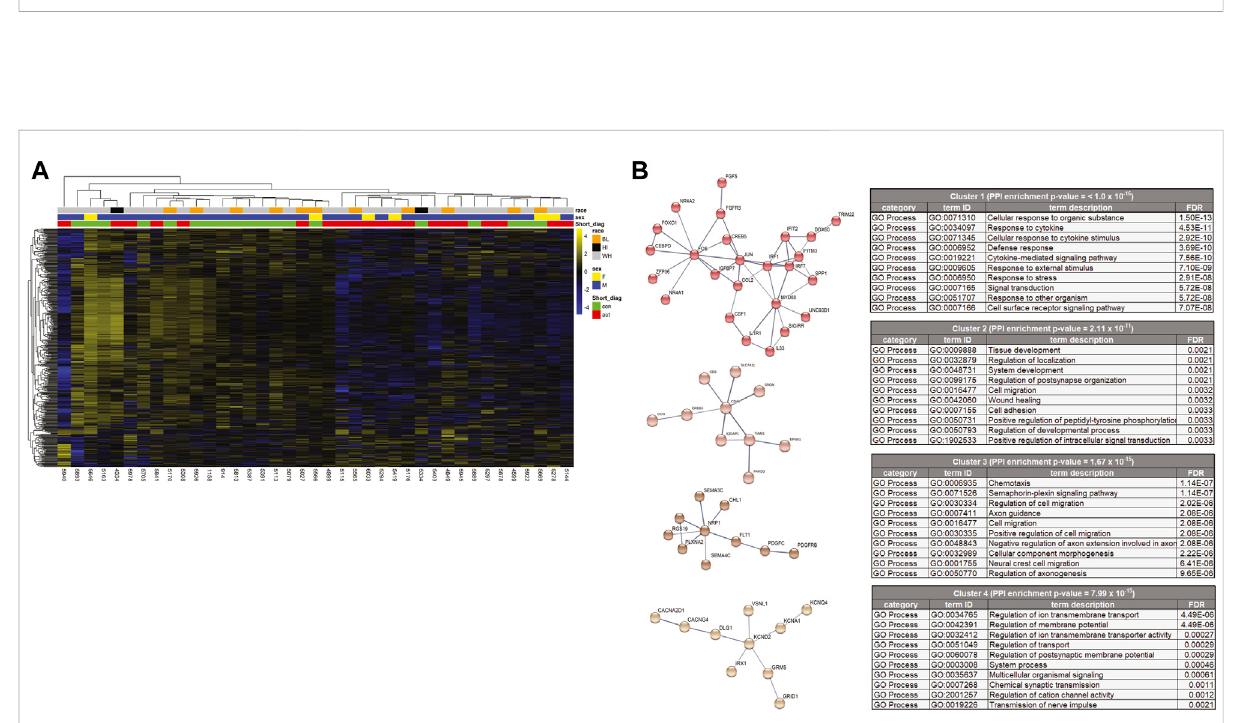
FIGURE 2 (A) Heat map of differentially expressed genes. Of the total 427 differently expressed genes, 360 were down-regulated and 67 were up- regulated in ASD cases. Both the genes (rows) and cases (columns) were clustered using dendrograms constructed using Euclidean distances and hierarchical clustering and grouped by case demographics. (B) STRINGdb analysis of the differentially expressed genes that were decreased in the cases compared to the controls. The network was divided into clusters using the MCL in fl ation parameter and the top 4 clusters were analyzed for enrichment of Gene Ontology processes and the top 10 processes for each cluster are